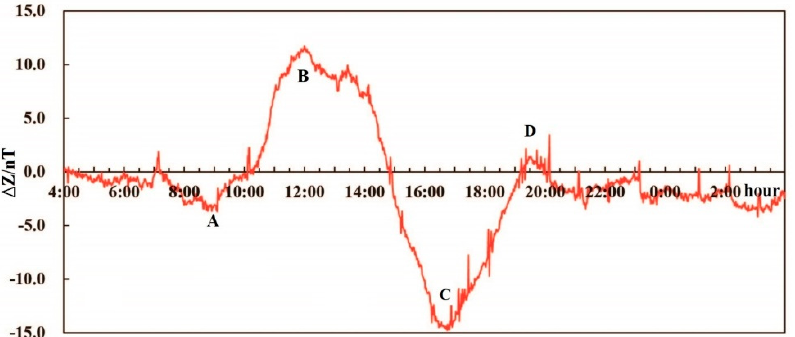
Figure 7. Variation amplitude obtained by using minute readings from 0400 LT on 9 May 2008 to 0400 LT on 10 May 2008, subtracting the corresponding average values during the period of 1–5 May at the CD station.